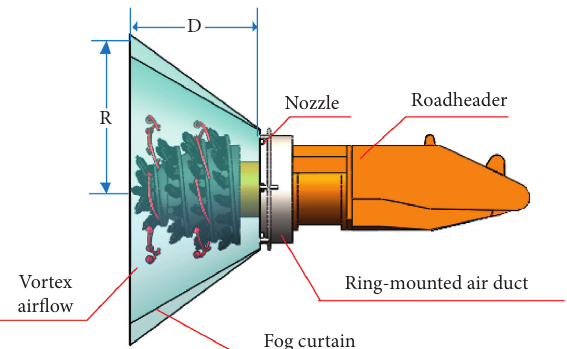
Figure 8: Ideal diagram of a new type of external aerodynamic vortex fog curtain (D represents the atomization range, and R represents the atomization radius).